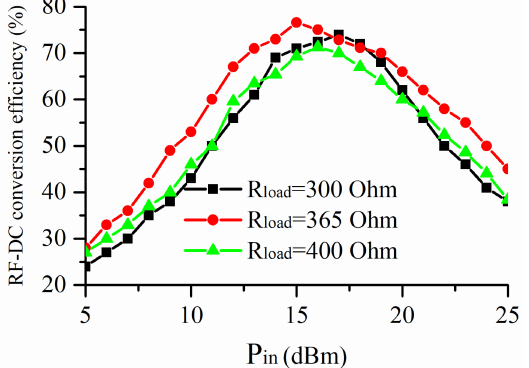
Figure 15. Measured RF–DC conversion efficiency under different loads R load and input power values P in , at port 2.